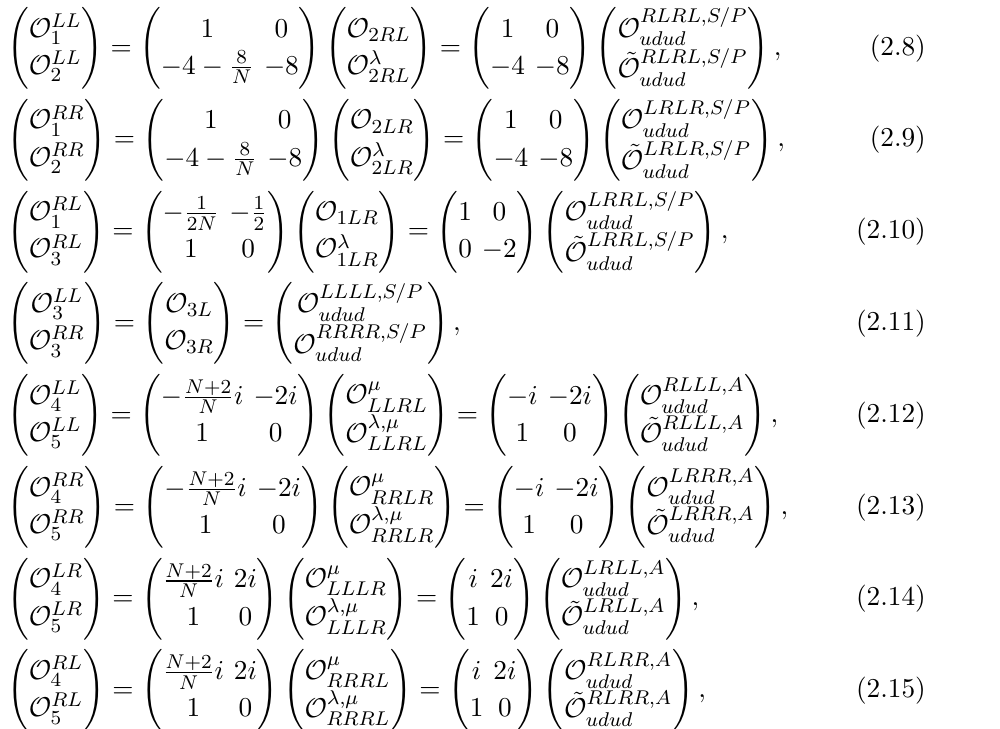
table 2. Using the above e(cid:11)ective Lagrangian we can match downwards the scale to heavy